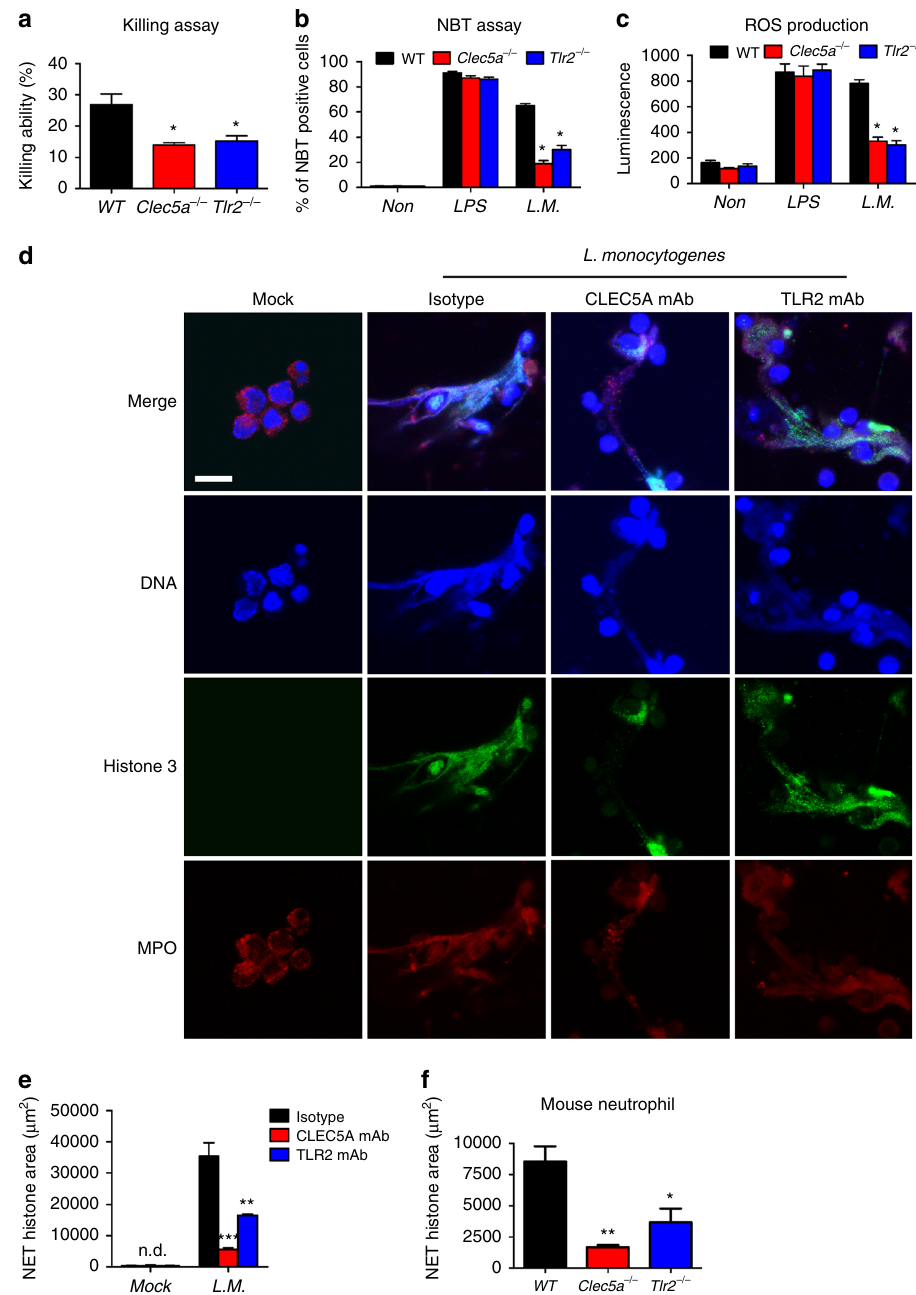
Fig. 2 CLEC5A is critical for L. monocytogenes -induced NETosis and ROS production. a Mouse neutrophils were incubated with live L. monocytogenes ( L.M .) (MOI 0.1) for 60 min to determine killing ability. b Neutrophils were co-incubated with L. monocytogenes (MOI 3) and NBT reagent for 60 min, followed by observation under a light microscopy to determine numbers of NBT-positive cells from the average of fi ve individual fi elds in each group. c ROS production was measured by luminescence at 10-min intervals for 120 min, and the representative ROS production in each group is shown as luminescence intensity at 60 min post L. monocytogenes infection. d Human neutrophils were pretreated with anti-CLEC5A and anti-TLR2 mAbs (3 μ g/ml), respectively, at room temperature for 30 min before incubation with L. monocytogenes (MOI 5). NET structures were analyzed 180 min post-infection by immuno fl uorescence staining using Hoechst 33342 ( blue ), anti-MPO ( red ) and anti-histone ( green ) mAbs. Scale bar , 30 μ m. e The NET quanti fi cation is displayed as NET histone area ( μ m 2 ) /per fi led. f Mouse neutrophils were incubated with bacteria (MOI 10) for 90 min, and NET formation was quanti fi ed by determining histone area ( μ m 2 )/per fi led. All the data were collected and expressed as mean ± s.e.m. from at least three independent experiments. One-way ANOVA was performed. * P < 0.05, ** P < 0.01, *** P < 0.001 for treated versus control or knockout versus wild-type